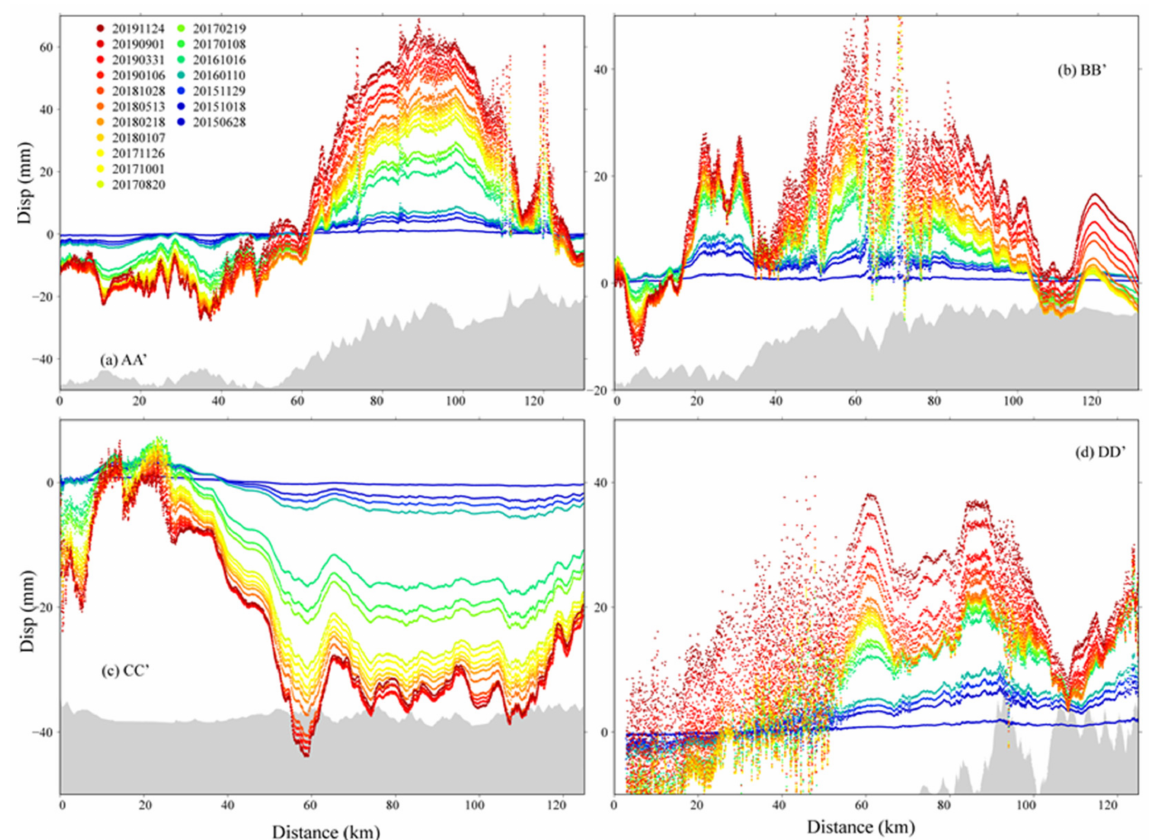
Figure 7. Cumulative displacement Profiles for the 4.5 yr after the Nepal Mw 7.8 earthquake, the profile locations are given in Figure 5a, and gray polygons denote topography along the profiles.